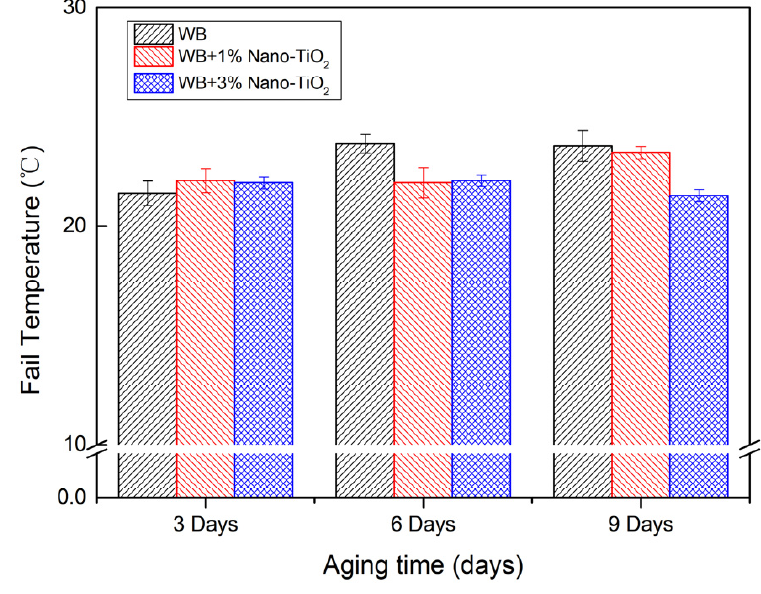
Figure 5. Fail temperatures of UV-aged